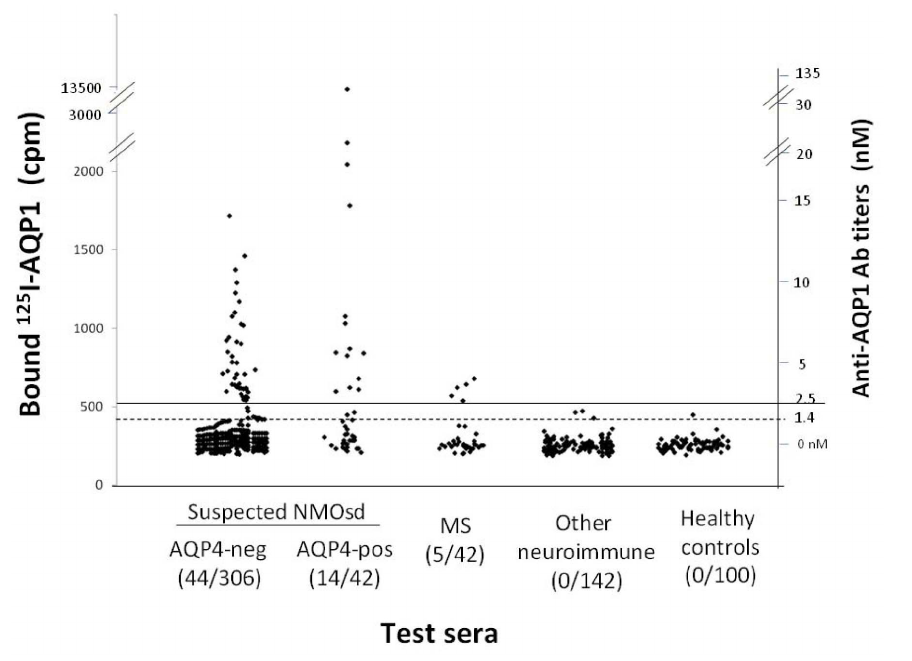
Figure 1. Measurement of anti-AQP1 antibodies in the sera of different patient groups and healthy controls by RIPA . The serum samples are (left to right) from patients with suspected NMOsd without (AQP4-neg) or with (AQP4-pos) anti-AQP4 antibodies, MS, other neuroimmune diseases (131/142 with MG), or healthy controls. The numbers in parenthesis below the group are the number of anti-AQP1 antibody- positive sera and the total number of test sera for each group of patients. The dashed and solid horizontal lines denote the cut-off values for ambiguous and positive titers. The left and right y axis show, respectively, the precipitated cpm and the estimated antibody titer.